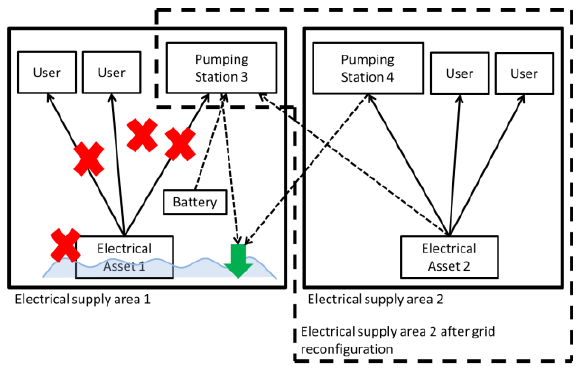
Figure 1. Concepts and processes within crisis scenario of flood-caused power